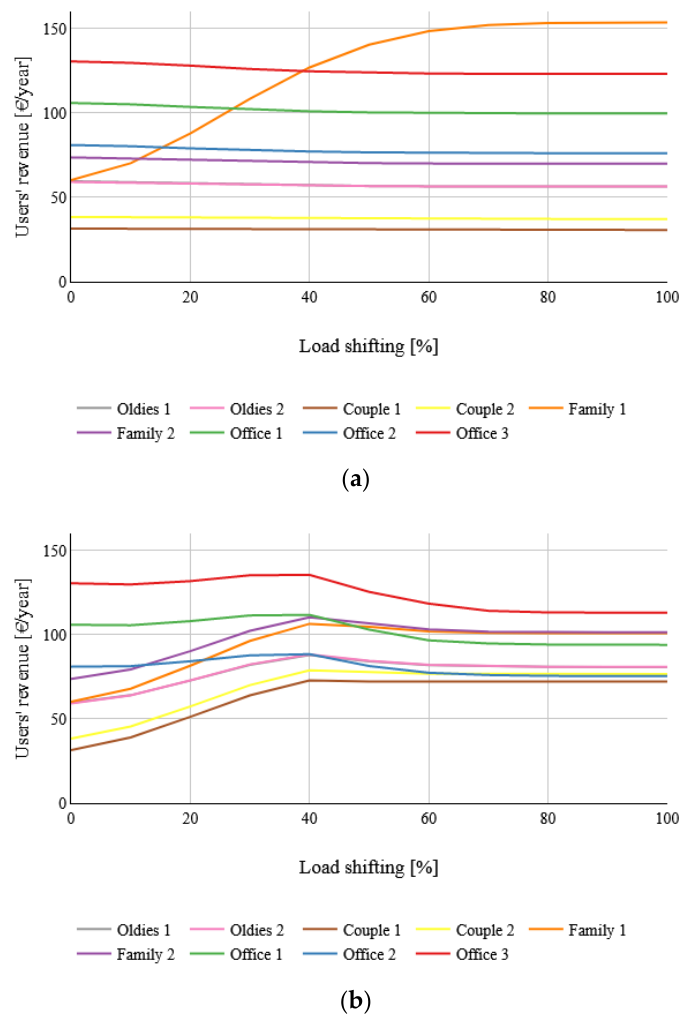
Figure 2. Impact of load shifting on the yearly revenues for each member of the configuration in Scenario A-EC: ( a ) only Family 1 is performing load shifting; ( b ) all the passive members are performing load shifting.